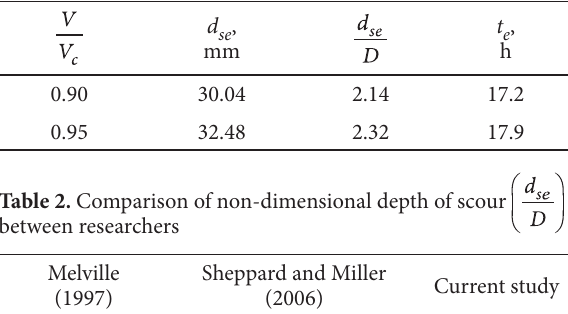
Table 1. Time and depth of equilibrium scour